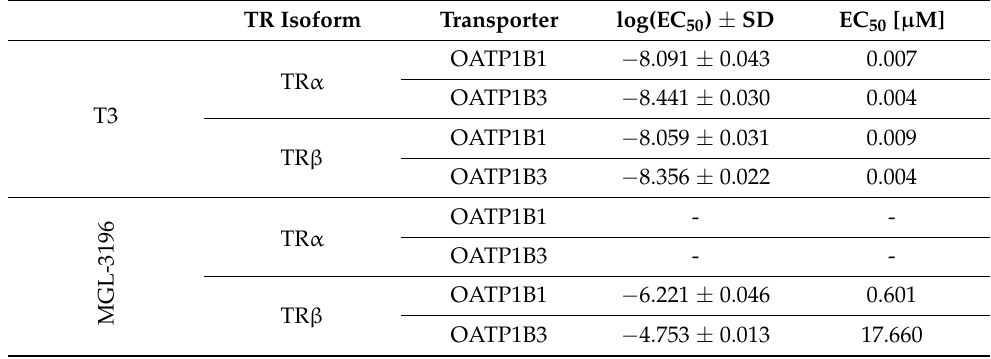
Table 1. EC 50 values for T 3 and